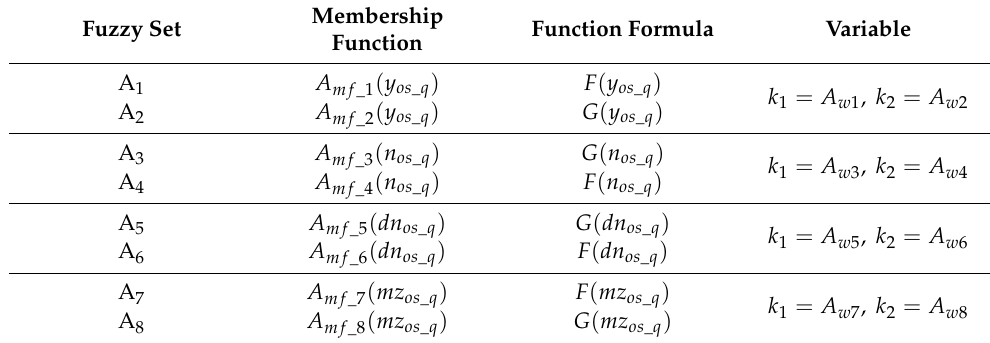
Table 6. The relationship between the fuzzy sets and membership function. Fuzzy Set